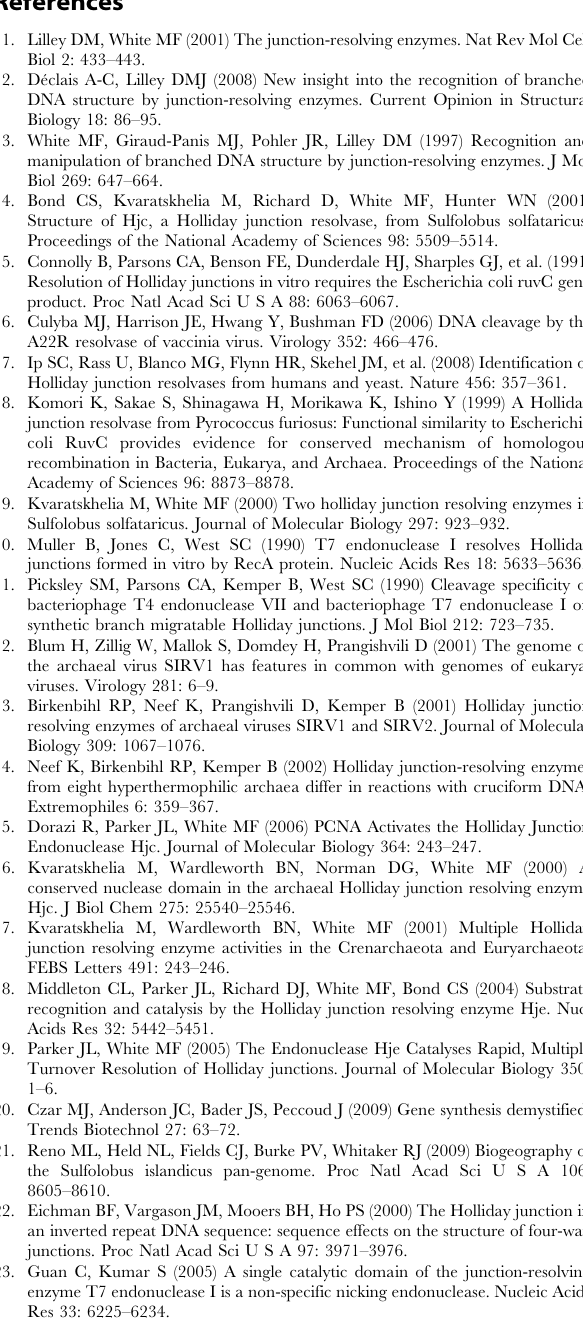
Table S1 Oligonucleotides for SIRV2gp26, SIRV2 Hjr, and S. islandicus Hje gene synthesis. (DOC) Table S2 Oligonucleotides for DNA substrates. (DOC) Table S3 Proteins that interact with MBP-SIRV2 Hjr.